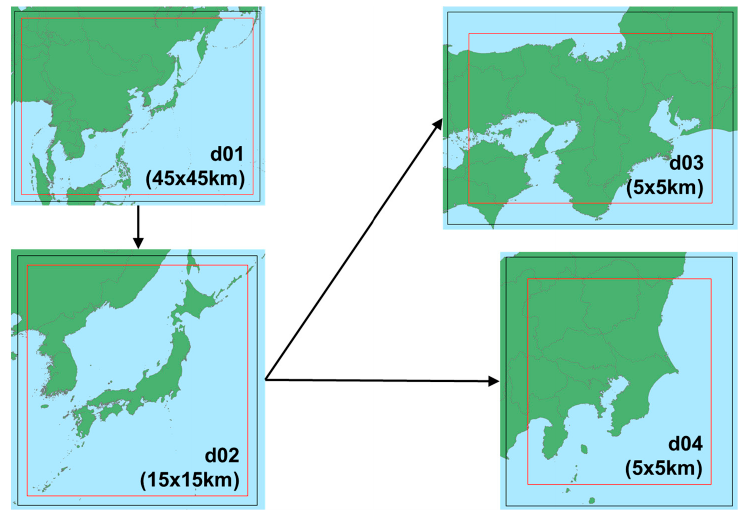
Figure 1. Four nested target domains.